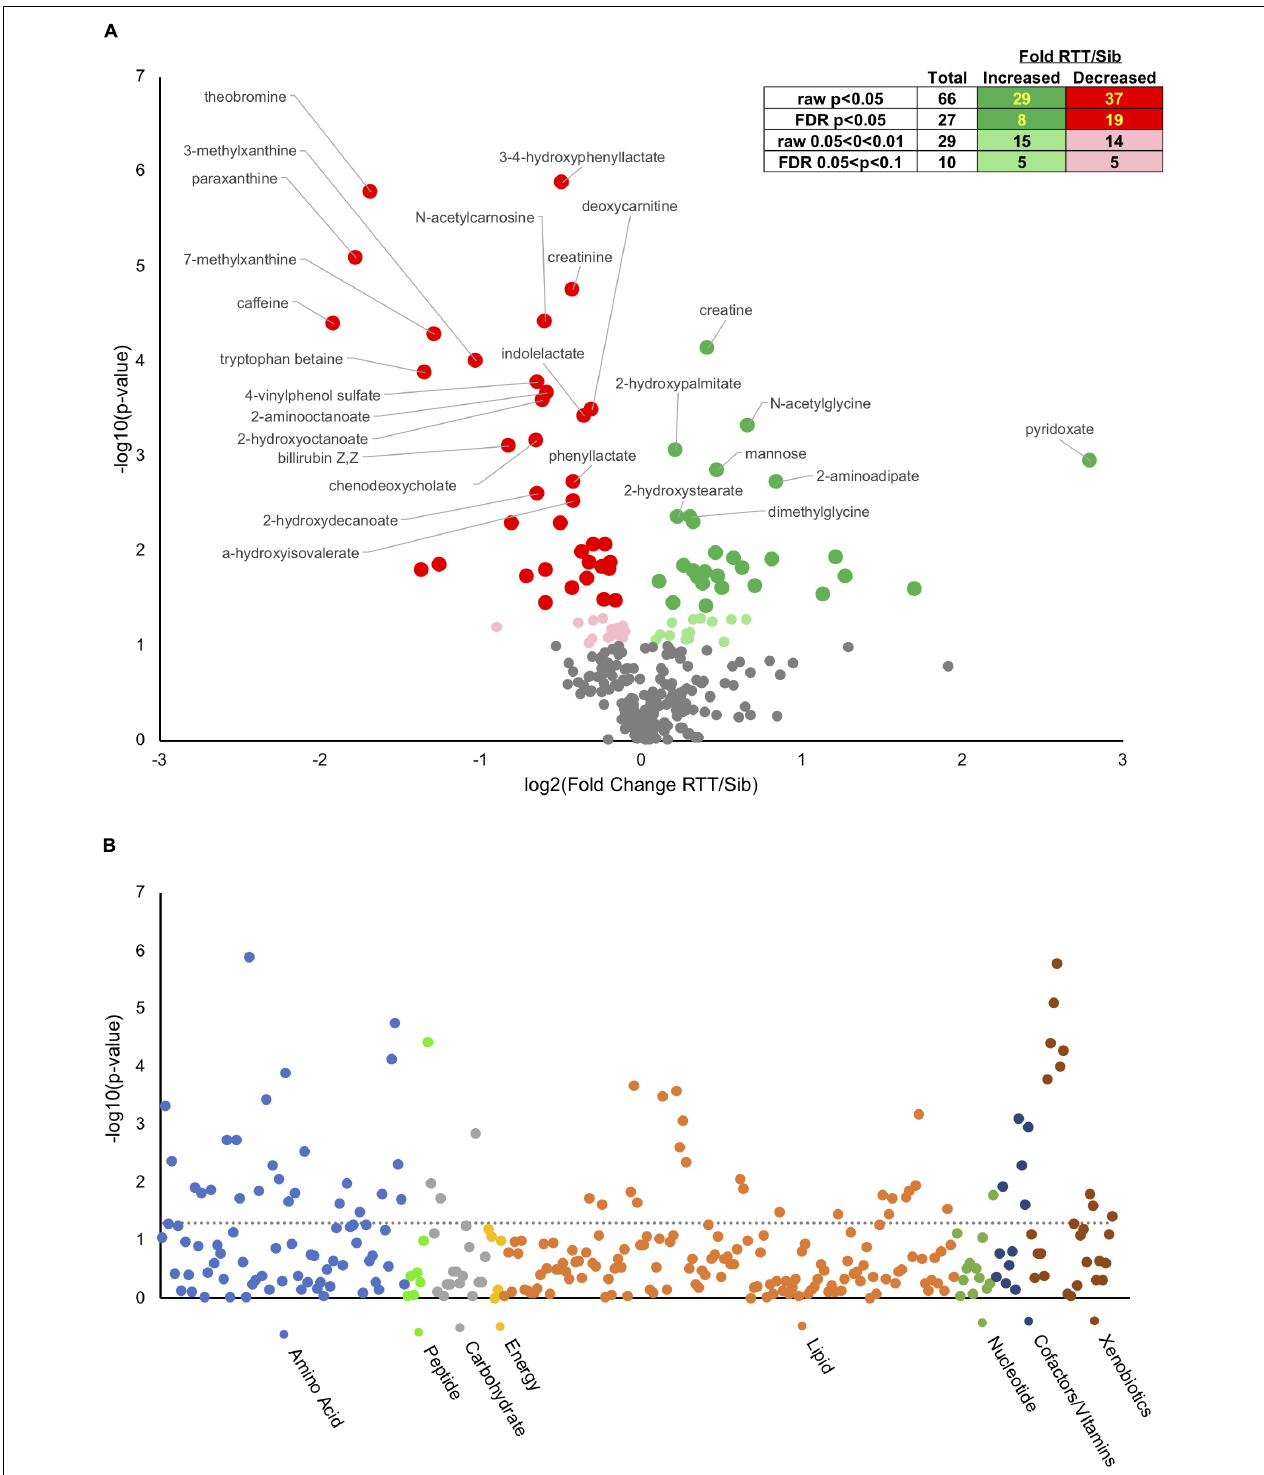
FIGURE 1 | Metabolic changes in RTT compared with unaffected siblings. (A) Volcano plot showing negative log10( p -values) on y -axis and log2(Fold change RTT/sibling) on x -axis. Inset table shows number of metabolites at different raw or FDR corrected p -value and the distribution between increased in RTT compared to siblings or decreased. Dark green, increased p < 0.05, light green increased 0.05 < p < 0.1. Dark red, decreased p < 0.05, pink decreased 0.05 < p < 0.1. (B) Manhattan plot displaying all metabolites characterized arranged by chemical groups on the x -axis, with the y -axis showing the negative log10( p -value) for each metabolite. The gray line indicates uncorrected p = 0.05. Color indicates chemical groupings as indicated along the x -axis.